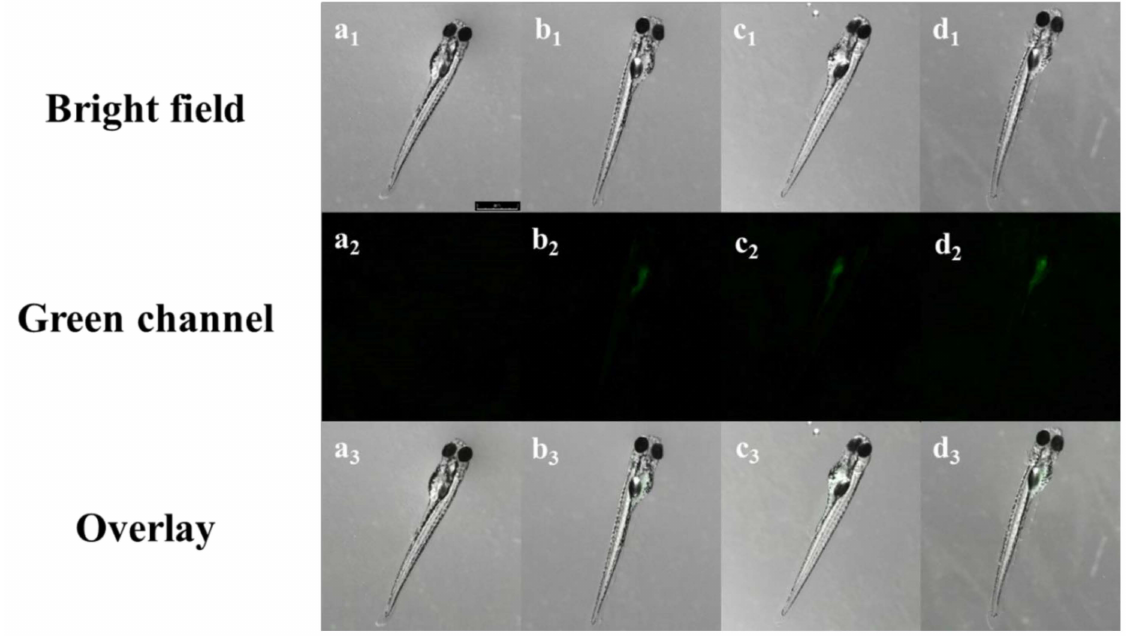
Figure 8. Fluorescence images of 6-day-old zebrafish exposed to TCC followed by the addition of Zn 2+ . ( a 1 – a 3 ): TCC only; ( b 1 – b 3 ): TCC with 150 µ M Zn 2+ ; ( c 1 – c 3 ): TCC with 250 µ M Zn 2+ ; and